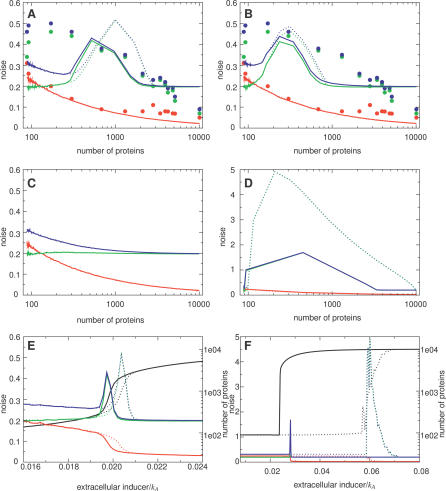
Noise Levels in the Model Compared with the Experimentally Observed Noise(A) Noise as a function of the average number of proteins, for IPTG (kIPTG = 1.35/min). The red lines indicate intrinsic noise, the green lines extrinsic noise, and the blue lines total noise. The filled dots indicate the experimentally observed noise levels, adapted from [2]. Solid lines indicate that cells are initially induced, dotted lines that cells are initially repressed.(B) Noise levels in the model using the higher value for the protein-dependent inducer efflux and kIPTG = 0.10/min. The maximum in the extrinsic noise is shifted to lower protein numbers.(C) Noise levels in the model using lactose as inducer (default model), leading to much lower extrinsic noise.(D) Noise levels in the model using TMG as inducer (kTMG = 0/min), which leads to an increase of the extrinsic noise.(E) Noise as a function of extracellular IPTG concentrations. Inducer concentrations are scaled relative to the binding affinity of the inducer with LacI, the repressor protein of the operon. The black curves indicate the mean protein number.(F) Noise as a function of extracellular TMG concentrations.